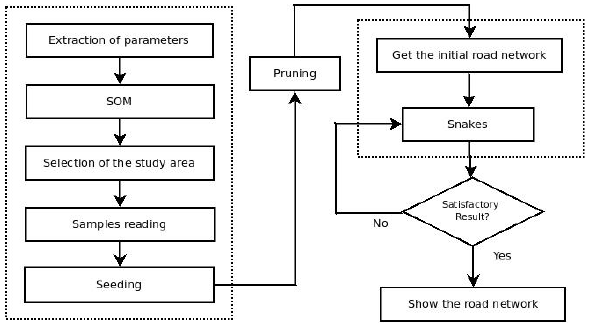
Figure 1: Fluxogram of the road extractor